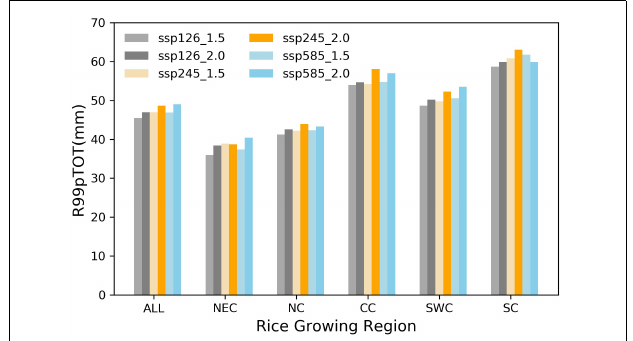
FIGURE 11 | Distribution of warm days (TX90p) at 1.5 and 2 ◦ C. (A–C) Global warming at 1.5 ◦ C under SSP126, SSP245, and SSP585, respectively. (D–F) Global warming at 2 ◦ C under SSP126, SSP245, and SSP585, respectively. (G–I) The differences between global warming at 1.5 and 2 ◦ C.